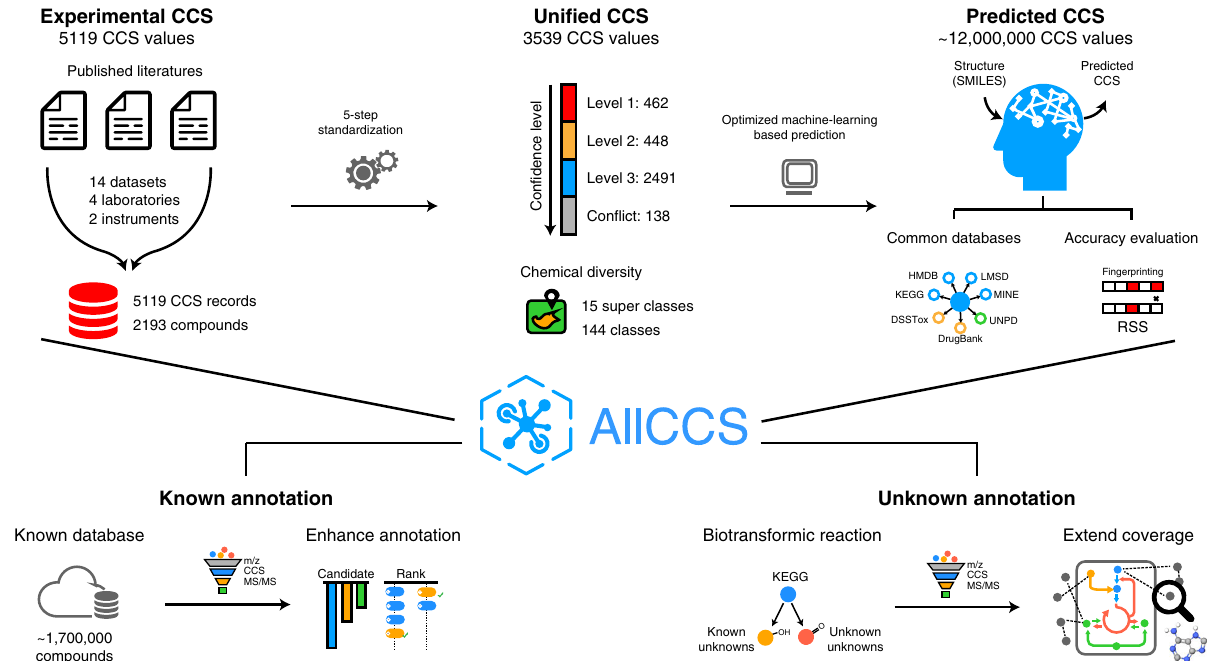
Fig. 1 Overview of AllCCS atlas and annotation of known and unknown metabolites. The AllCCS atlas hosts 5119 experimental CCS records, 3539 uni fi ed CCS values, and ~12 million predicted CCS values for ~1.7 million compounds. AllCCS can be integrated with in-silico MS/MS spectra to enable the multi- dimensional annotation for known and unknown metabolites in untargeted